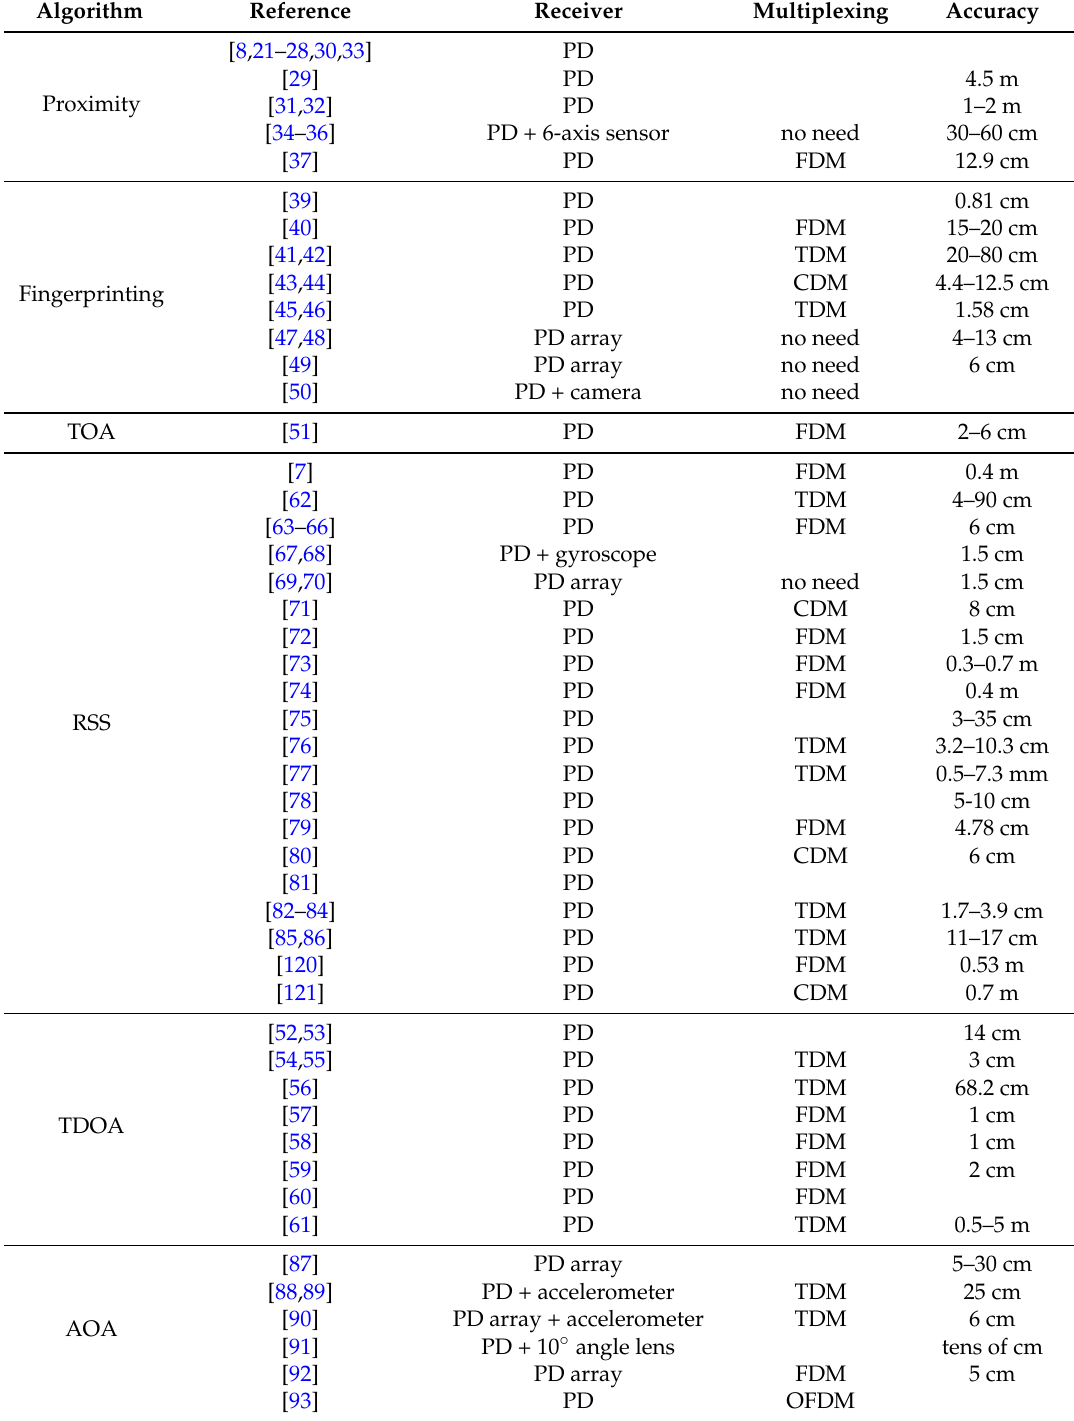
Table 1. Summary of different positioning